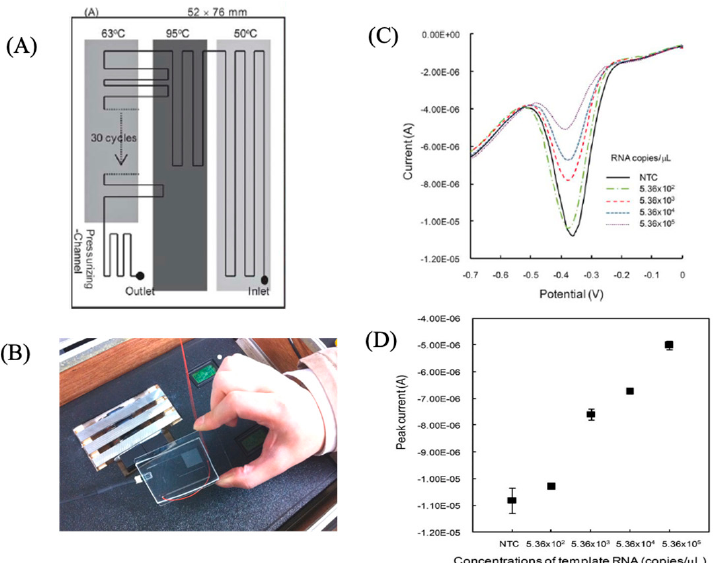
Figure 15. RT-PCR microfluid chip with screen printed electrode [12]. ( A ) Microfluidic RT-PCR chip with fixed temperature heaters of 63 °C, 95 °C and 50 °C; ( B ) Photograph of ( A ); ( C ) Square Wave Voltammetry of RT-PCR products of different copies of RNA samples; ( D ) Relationship between of peak currents and RT-PCR products of different copies of RNA samples.